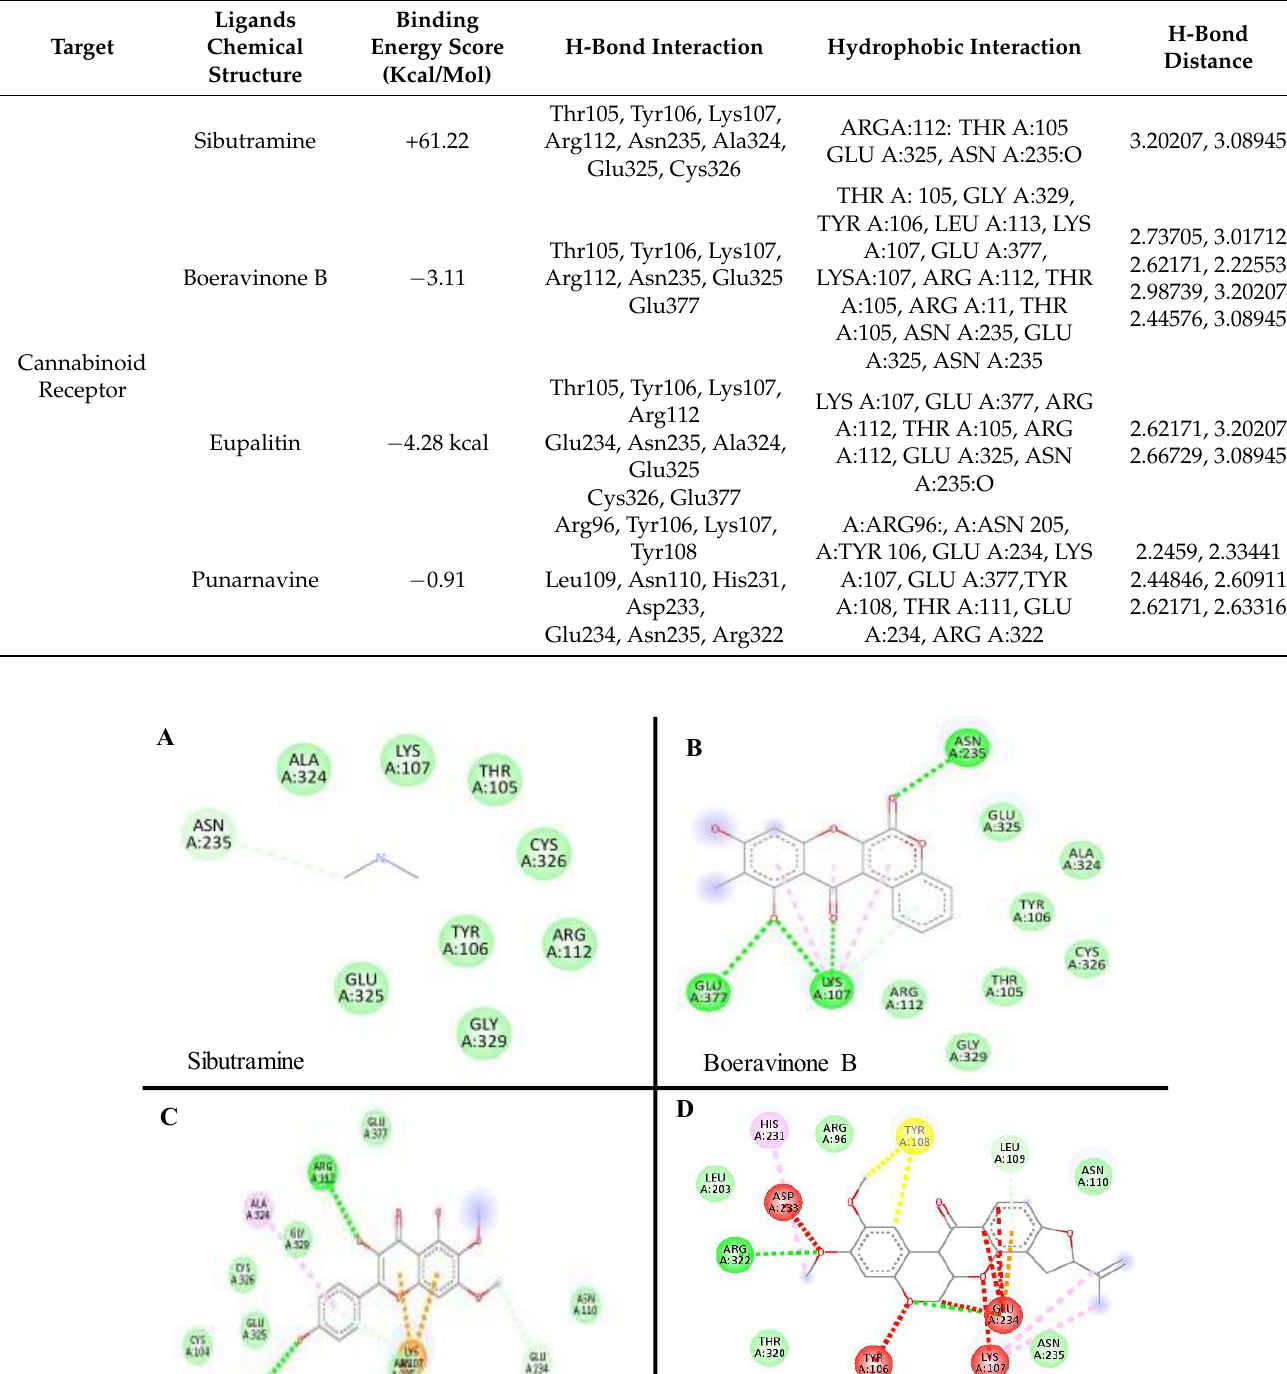
Figure 3. Pictorial representation of molecular docking analysis. ( A ) Binding orientation in the docked complex of CR with Eupalitin. ( B ) Surface representation of the CR bind- ing pocket with the Eupalitin. The compound Eupalitin is represented in green. Images were generated using Discovery Studio visualizer. i ure Pi toria re re entation o mo e u ar o in ana